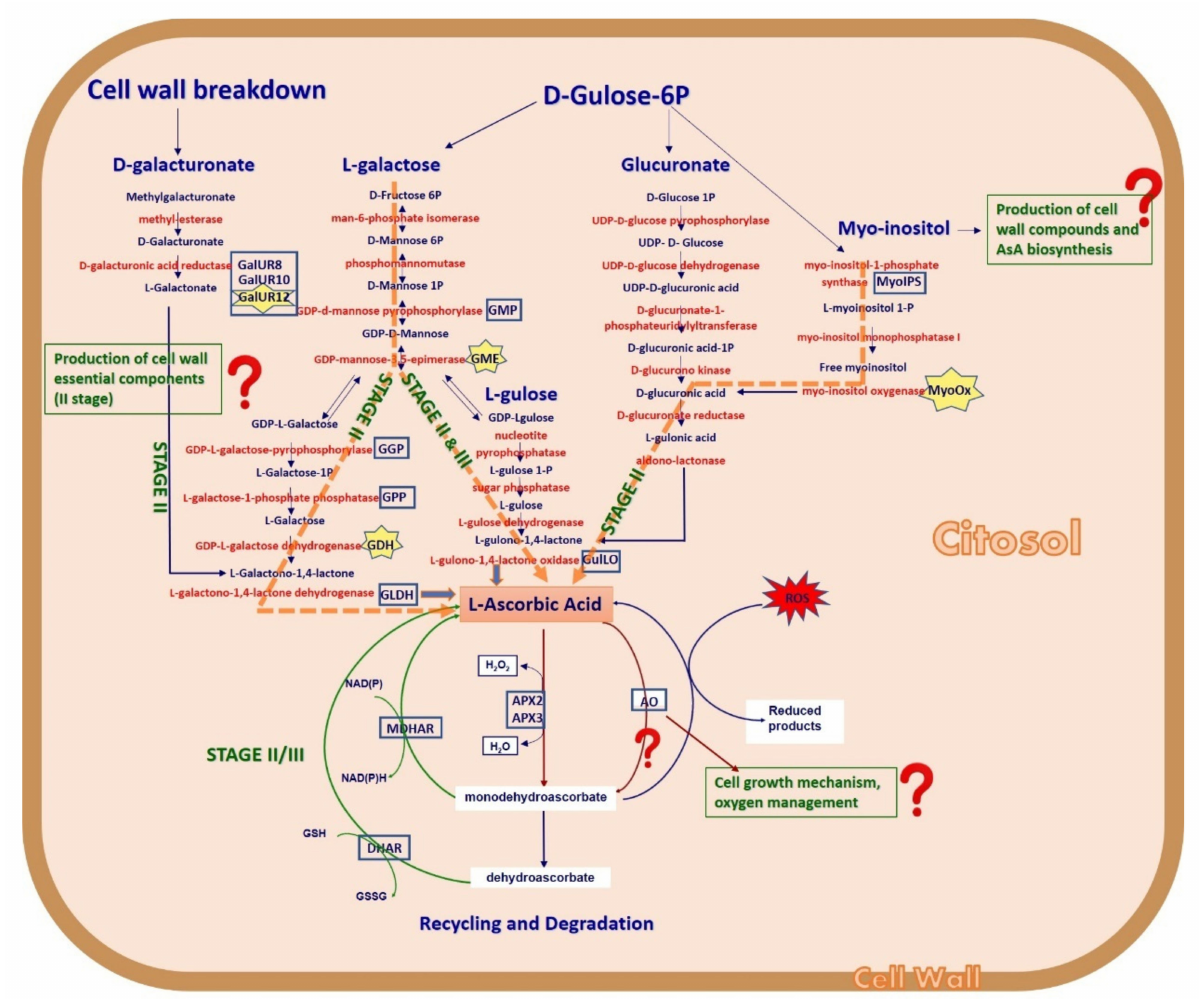
Figure 1. Conceptual drawing of ascorbate metabolism in citrus. This scheme represents a potential flow of reactions of the metabolism of AsA based on the data from this work and the published literature. Green capital letters indicate the periods in which the pathways occur in the biosynthesis of AsA. We hypothesize that the L -galactose and Myo-inositol pathways act during stage II through the glucuronate pathway, while L -gulose is involved in stages II and III. The recycling and degradation pathways would operate in both stages. Question marks indicate possible alternative reactions. Blue rectangles indicate genes we focused on, and genes marked with a yellow star are those we found to be crucial for the accumulation of AsA in the juice. The green arrows indicate the recycling pathway, and the red arrows indicate the degradation